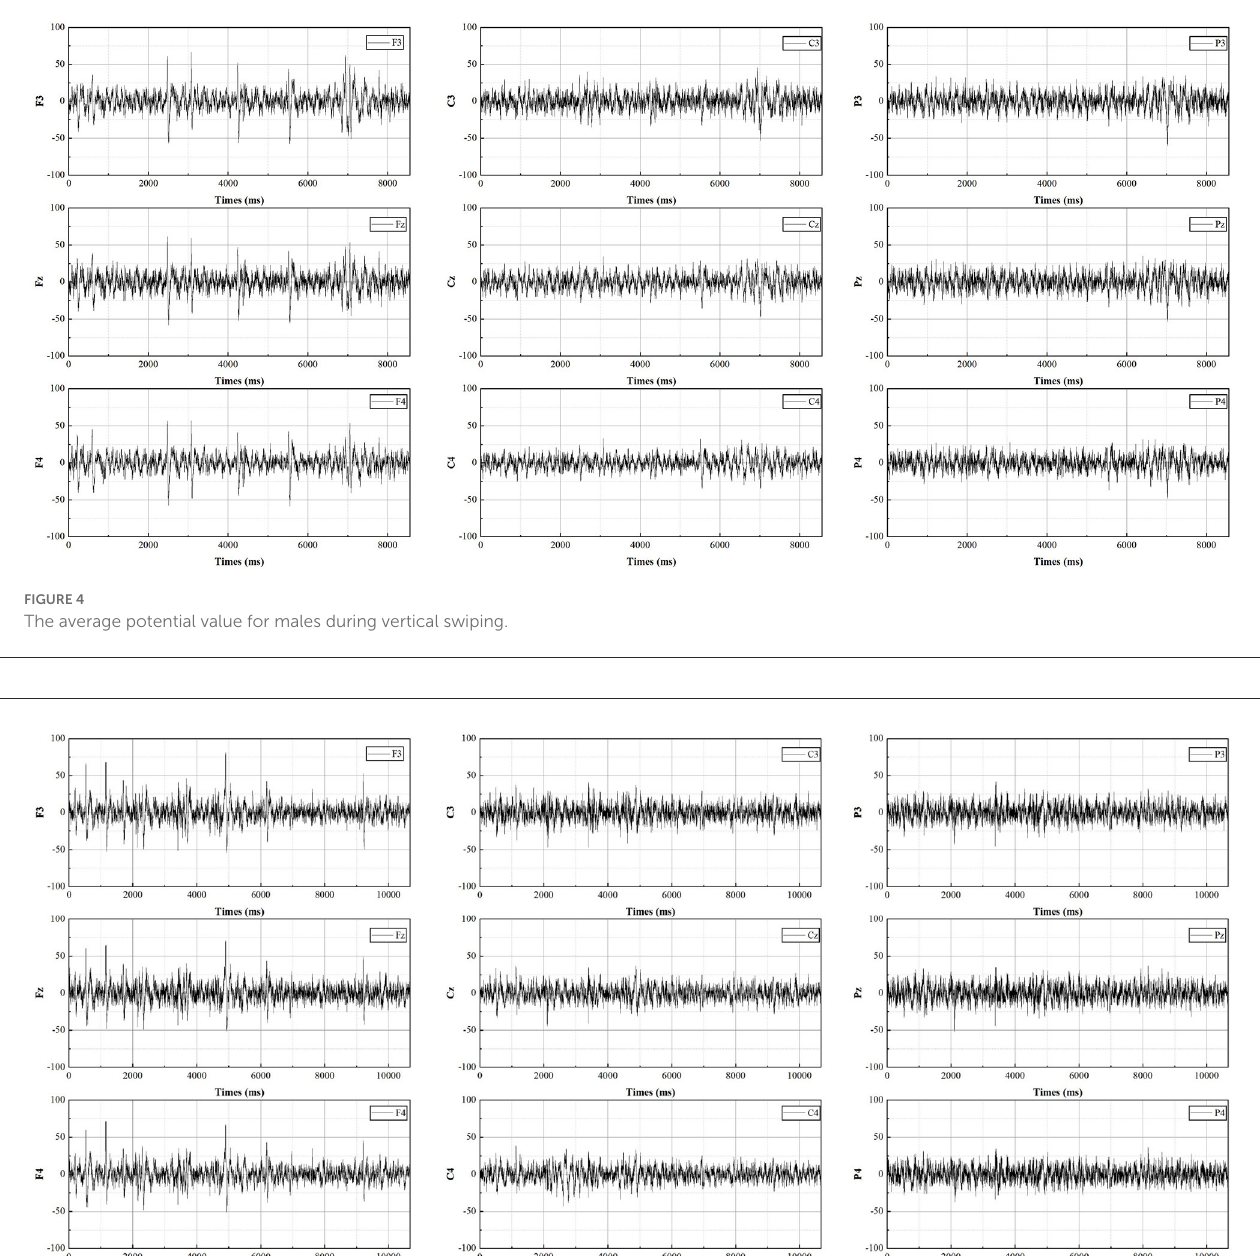
C4), and parietal (P3, Pz, P4) regions (Sun and Jin, 2021),